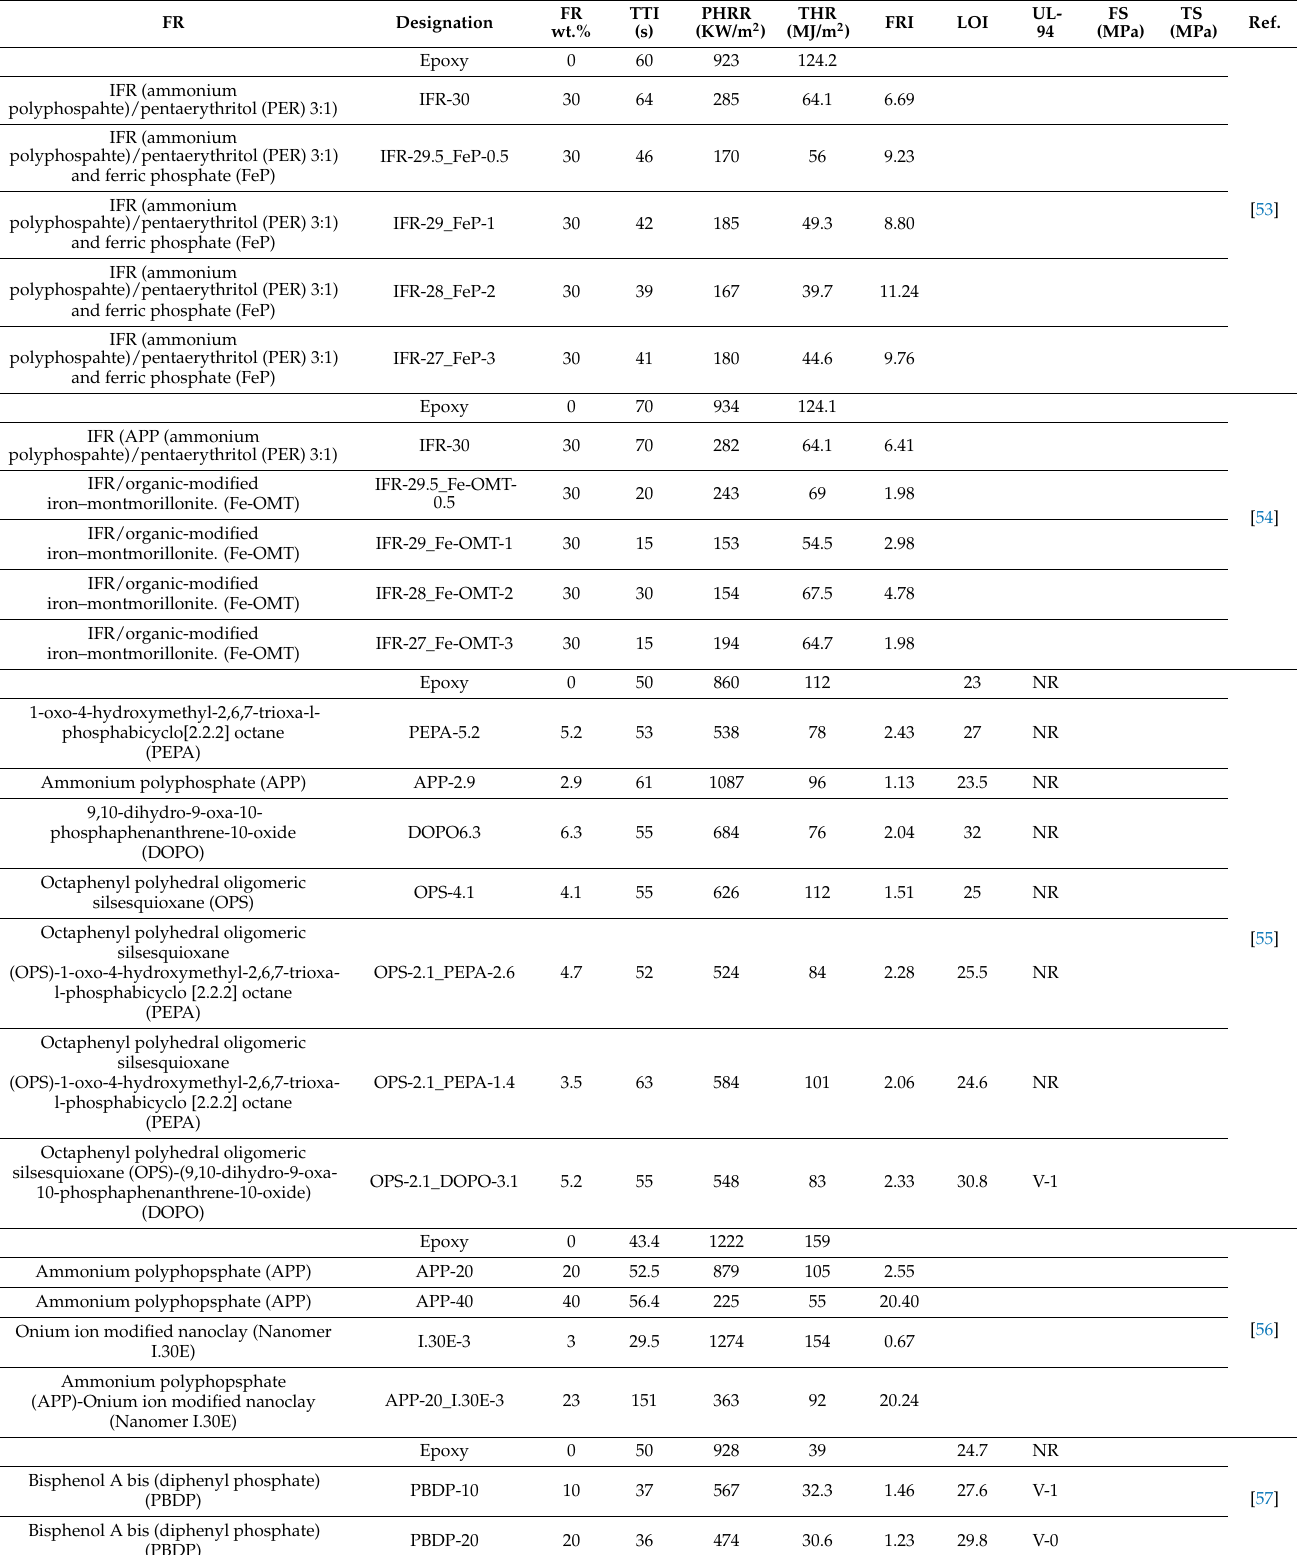
Table 4. Cone colorimetry data (TTI, PHRR, THR), Calculated FRI value, LOI, UL-94, FS and TS for epoxy resin filled with a wide variety of FR. The designation in column two referred to FR type followed by wt.% of